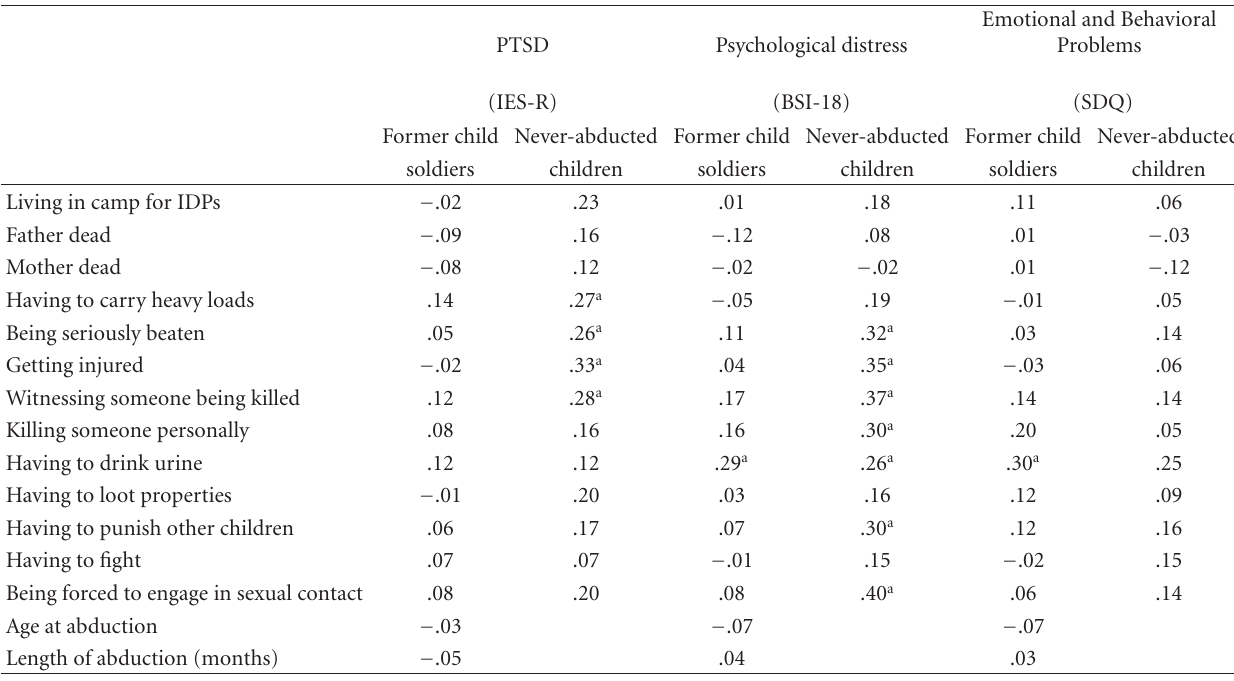
Table 3: Pearson correlation coe ffi cients of traumatic exposures and mental health problems among former child soldiers and never- abducted